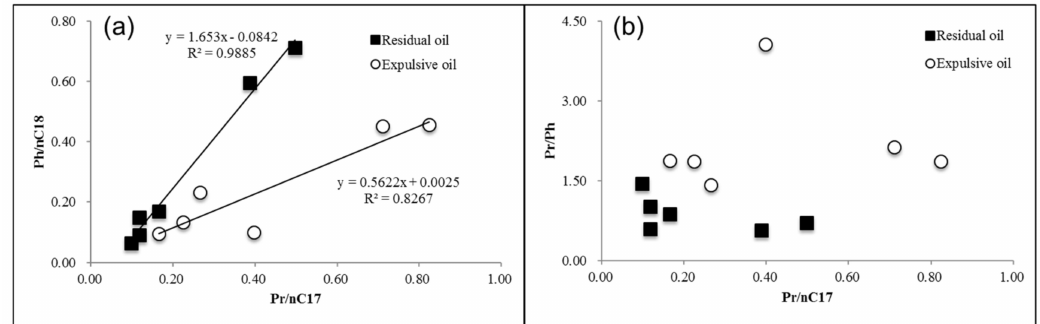
Figure 9. Plots of Ph/ n -C17 vs Pr/ n -C17 ( a ) and Pr/Ph vs Pr/ n -C17 ( b ) in expelled oil and residual oil in the different temperature pyrolysis products from